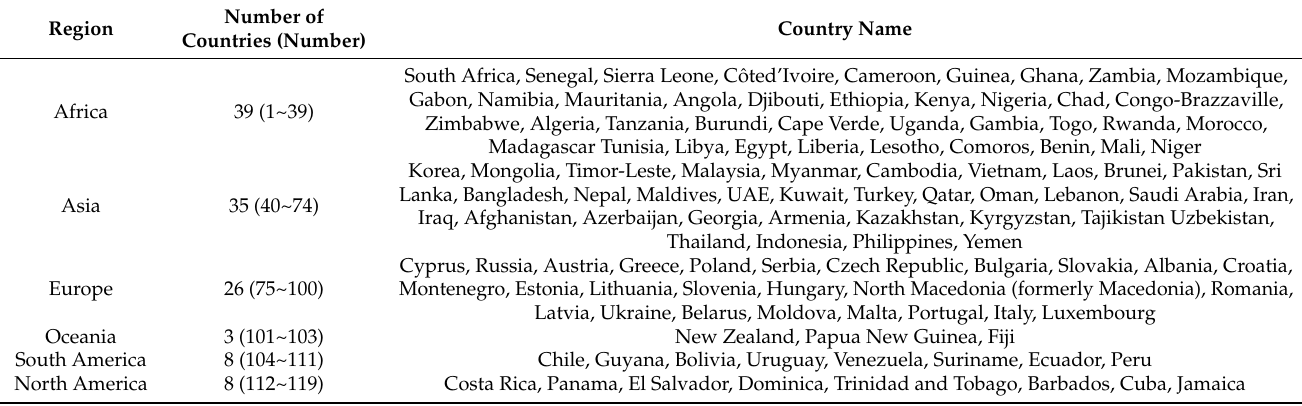
Table 1. Distribution of countries along with the “belt and road initiative”.